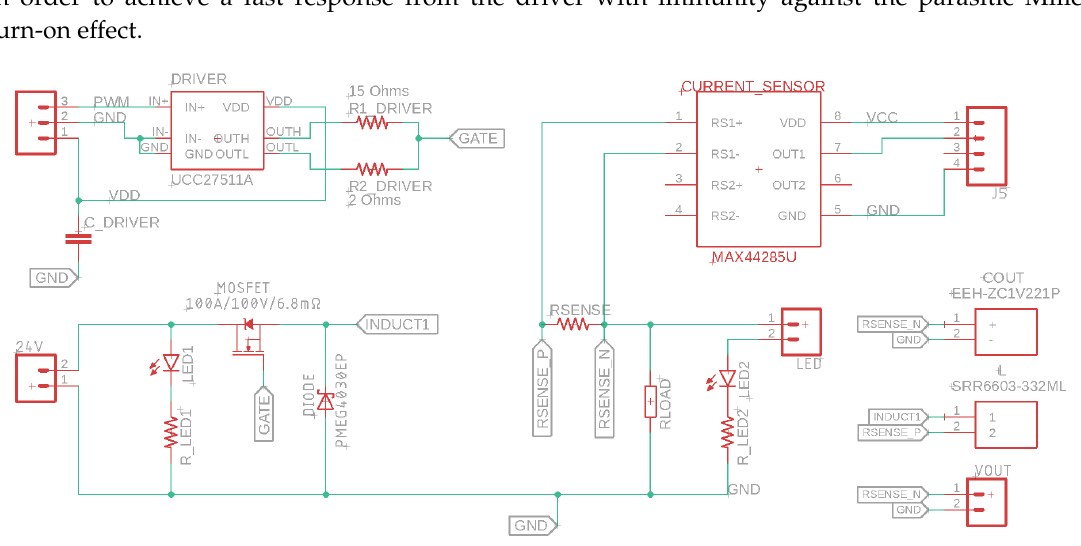
Figure 14. Schematic of the experimental testbed.